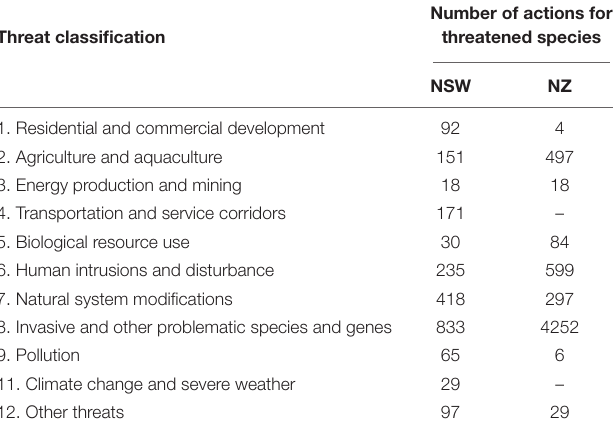
TABLE 1A | Number of threatened species in each broad IUCN threat class for NSW and NZ.